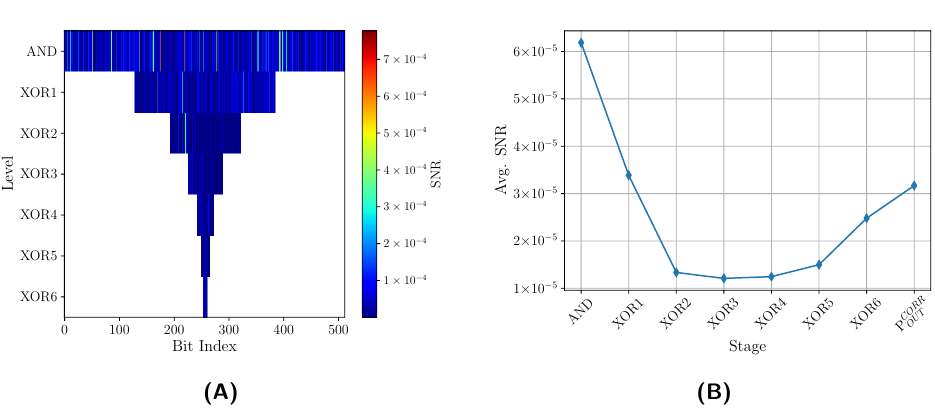
Figure 11: Maximum peaks of SNR by bit of the inner product module (AND and parallel XOR) (a), and average among peak values of the whole inner product module by layer (b).